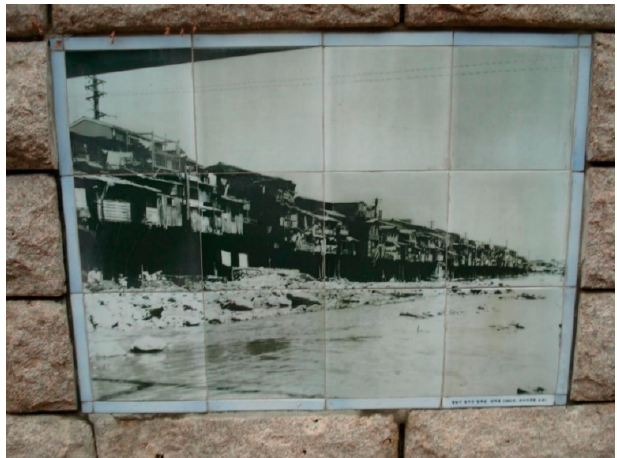
Figure 13. Image of shanty houses, dated 1961.